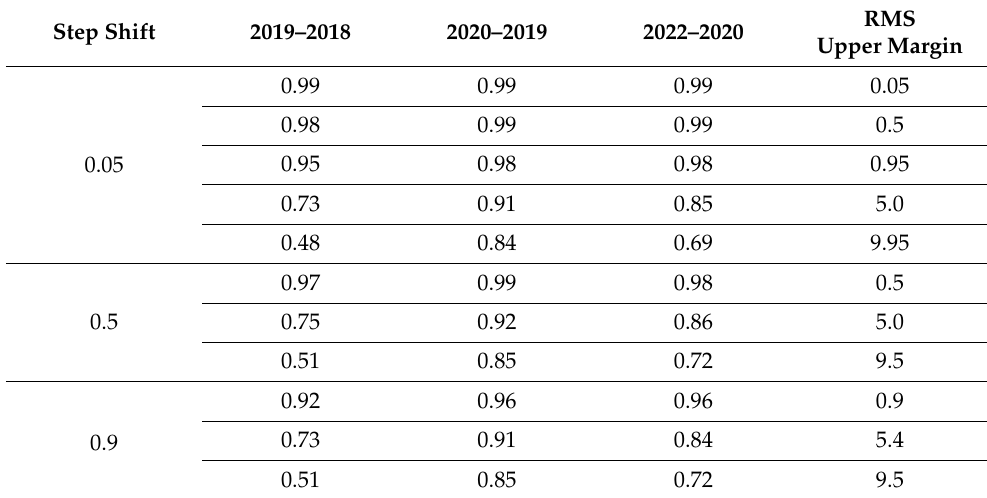
Table 3. Correlation values for each simulation step and RMS per period between the reference earthflow and simulated